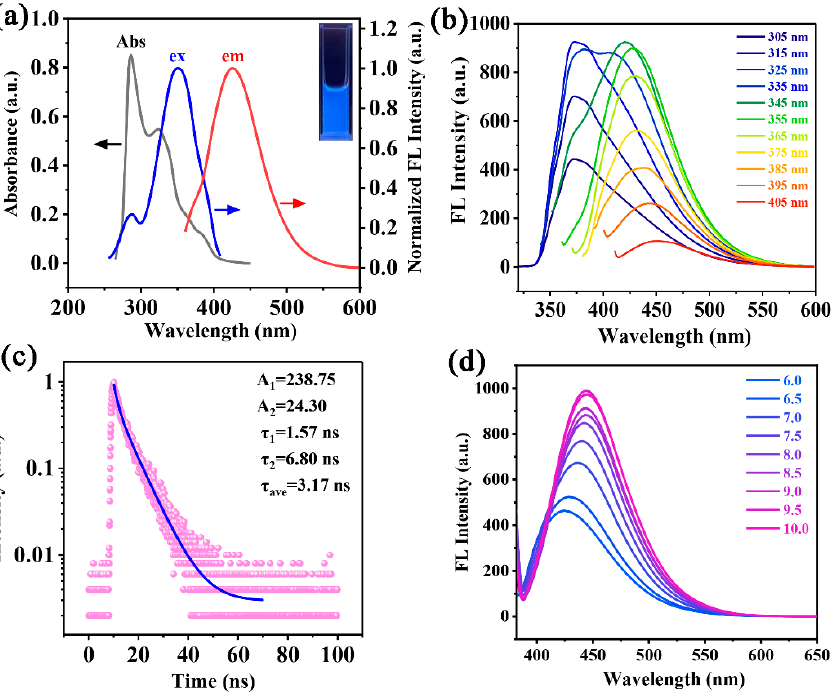
Figure 3. ( a ) UV − Vis absorption spectrum (black line), excitation spectrum (blue line), and emission spectrum (red line) of NCDs (inset: fluorescence image of NCDs). ( b ) Emission spectra of NCDs excited at different excitation wavelengths. ( c ) Fluorescence lifetime curve of NCDs, the blue line is the fitted result. ( d ) Fluorescence spectra and fluorescence intensity of NCDs at different pH levels.